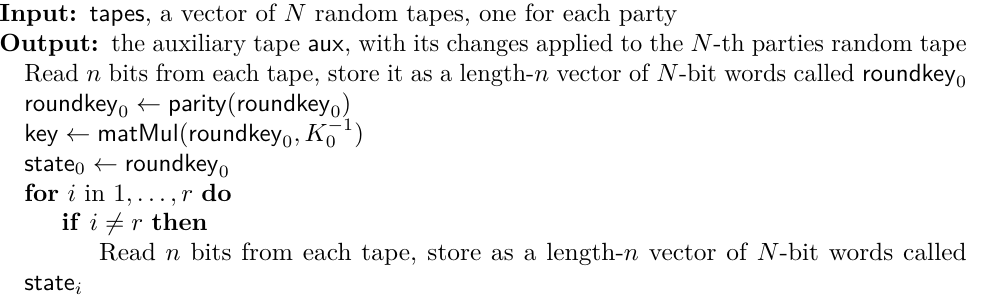
Algorithm 17 Simulation of Preprocessing phase in Picnic2 (after Section